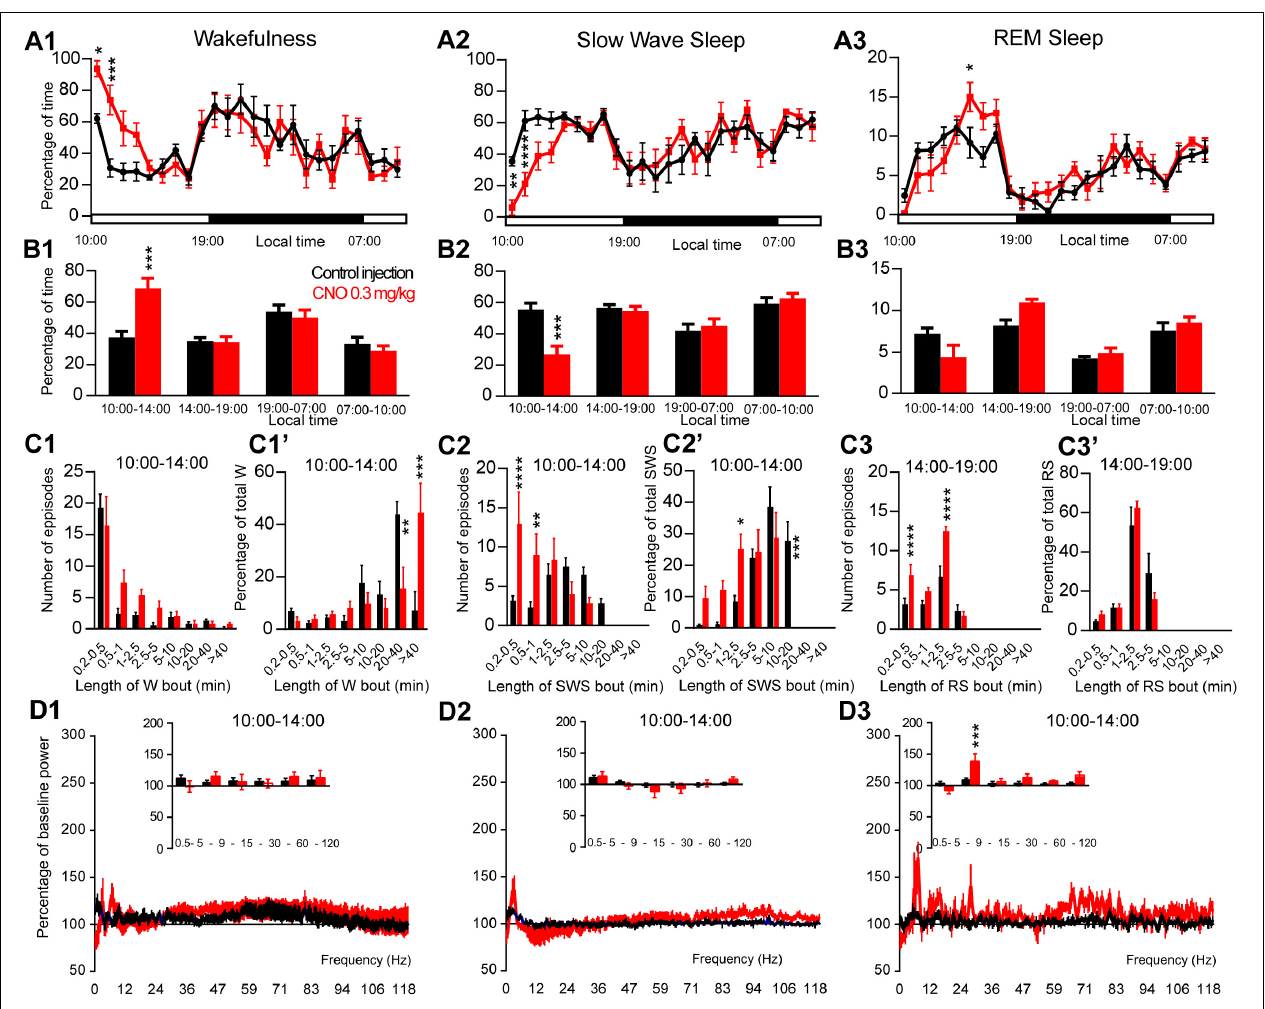
FIGURE 2 | Activation of PZ glutamatergic neurons during the inactive period (10:00 or ZT3). (A) Hourly amount of wakefulness (A1) , SWS (A2) and REM sleep (A3) following CNO (0.3 mg/kg, N = 6 mice) as compared with control injection. (B1–B3) Percentage of sleep-wake states ( ± S.E.M.) during the 4 h post-injection period (10:00–14:00), the remainder (5 h) of the light/sleep period (14:00–19:00), the subsequent 12 h light period and first 3 h of the light period of the next day (07:00–10:00, N = 6 mice). (C1–C3) Number of episodes ( ± S.E.M.) of wakefulness (W), SWS or REM sleep (RS) in each bout length and (C1’–C3’) time-weighted frequency histograms showing the proportion ( ± S.E.M.) of W, SWS or RS amounts in each bout length as a percentage of the total amount of W, SWS or RS during the 4 h post-injection period (10:00–14:00; N = 6). (D1–D3) Sleep-wake power spectrum changes over baseline during the 3 h (10:00–13:00) post CNO (0.3 mg/kg, N = 5 mice) injection time period as compared with control injection; and the quantitative changes ( ± S.E.M.) in power for the δ (0.4–5 Hz), θ (5–9 Hz), α (9–15 Hz), β (15–30 Hz), low γ (30–60 Hz) and high γ (60–120 Hz) frequency bands ( ± S.E.M.) following vehicle or CNO (0.3 mg/kg, N = 5 mice) administrations. Control injection in Black, CNO injection in red; ∗ p < 0.05, ∗∗ p < 0.01, ∗∗∗ p < 0.001, ∗∗∗∗ p < 0.0001, two-way ANOVA followed by a post hoc Bonferroni